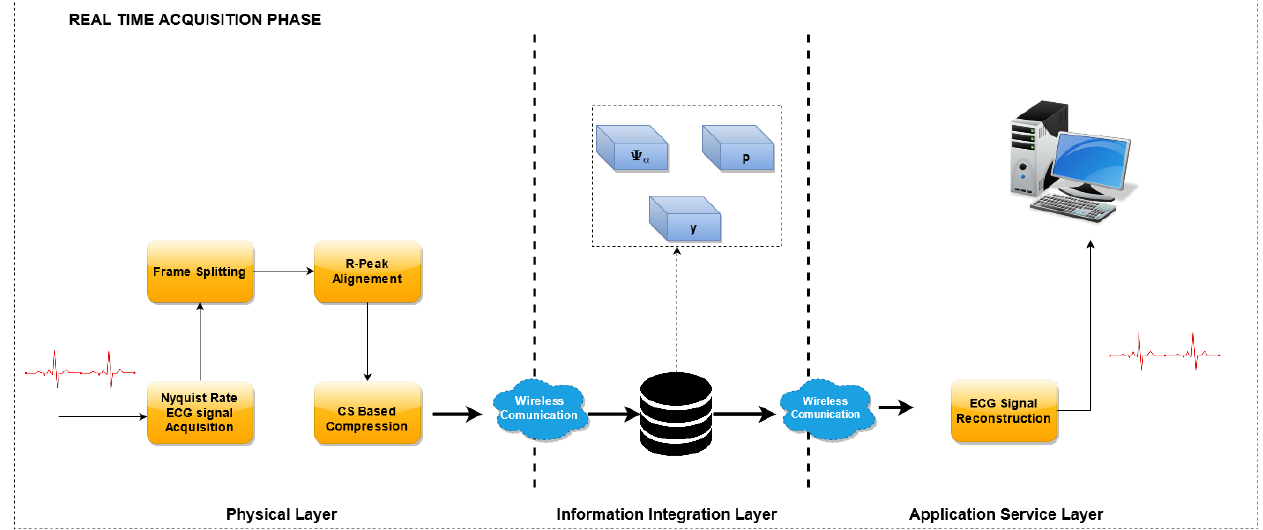
Figure 3. An overview of the utilization of the proposed dictionary matrix optimization process for continuous real-time ECG